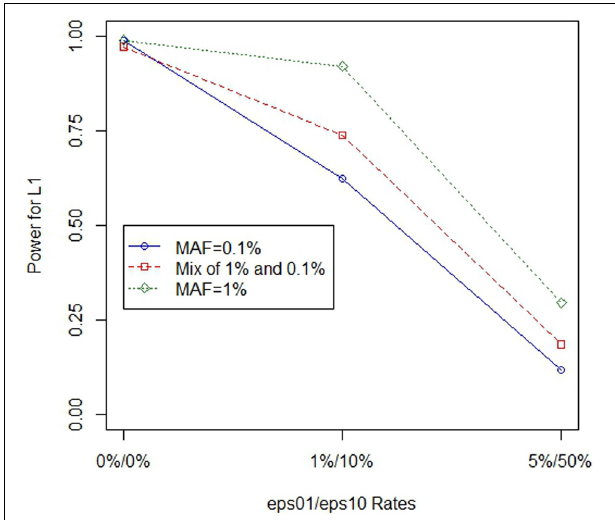
FIGURE 1 | Power for L 1 in the presence of non-differential genotype errors at different MAF. Power loss occurs when non-differential genotype errors are present at a locus. The power curves illustrated are at a site with eight causal variants. As genotype errors increase, power loss occurs.